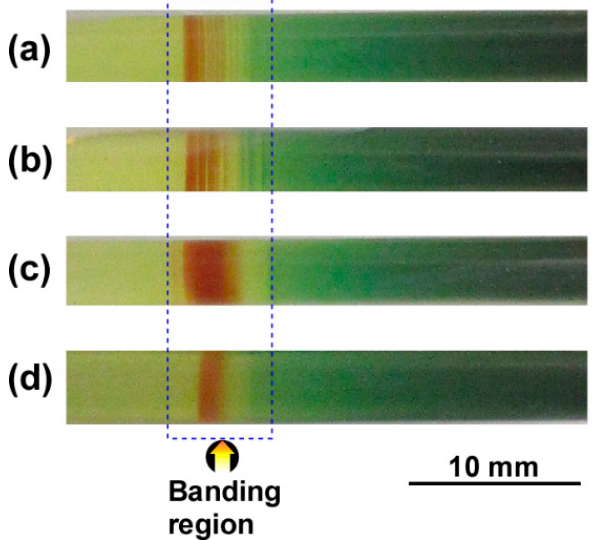
Figure 9. Stochastic formation of periodic bands under the cyclic alternating voltage application. Periodic bands such as ( a ) and ( b ) were generated with a probability of ~50%, and an almost continuous band such as ( c ) and ( d ) was generated in the other ~50% cases even under identical experimental conditions. These images were obtained at 90 h after the initial voltage application. The arrow at the bottom indicates the region where reddish–brown precipitation bands were formed. A scale bar is also provided at the bottom of the image.